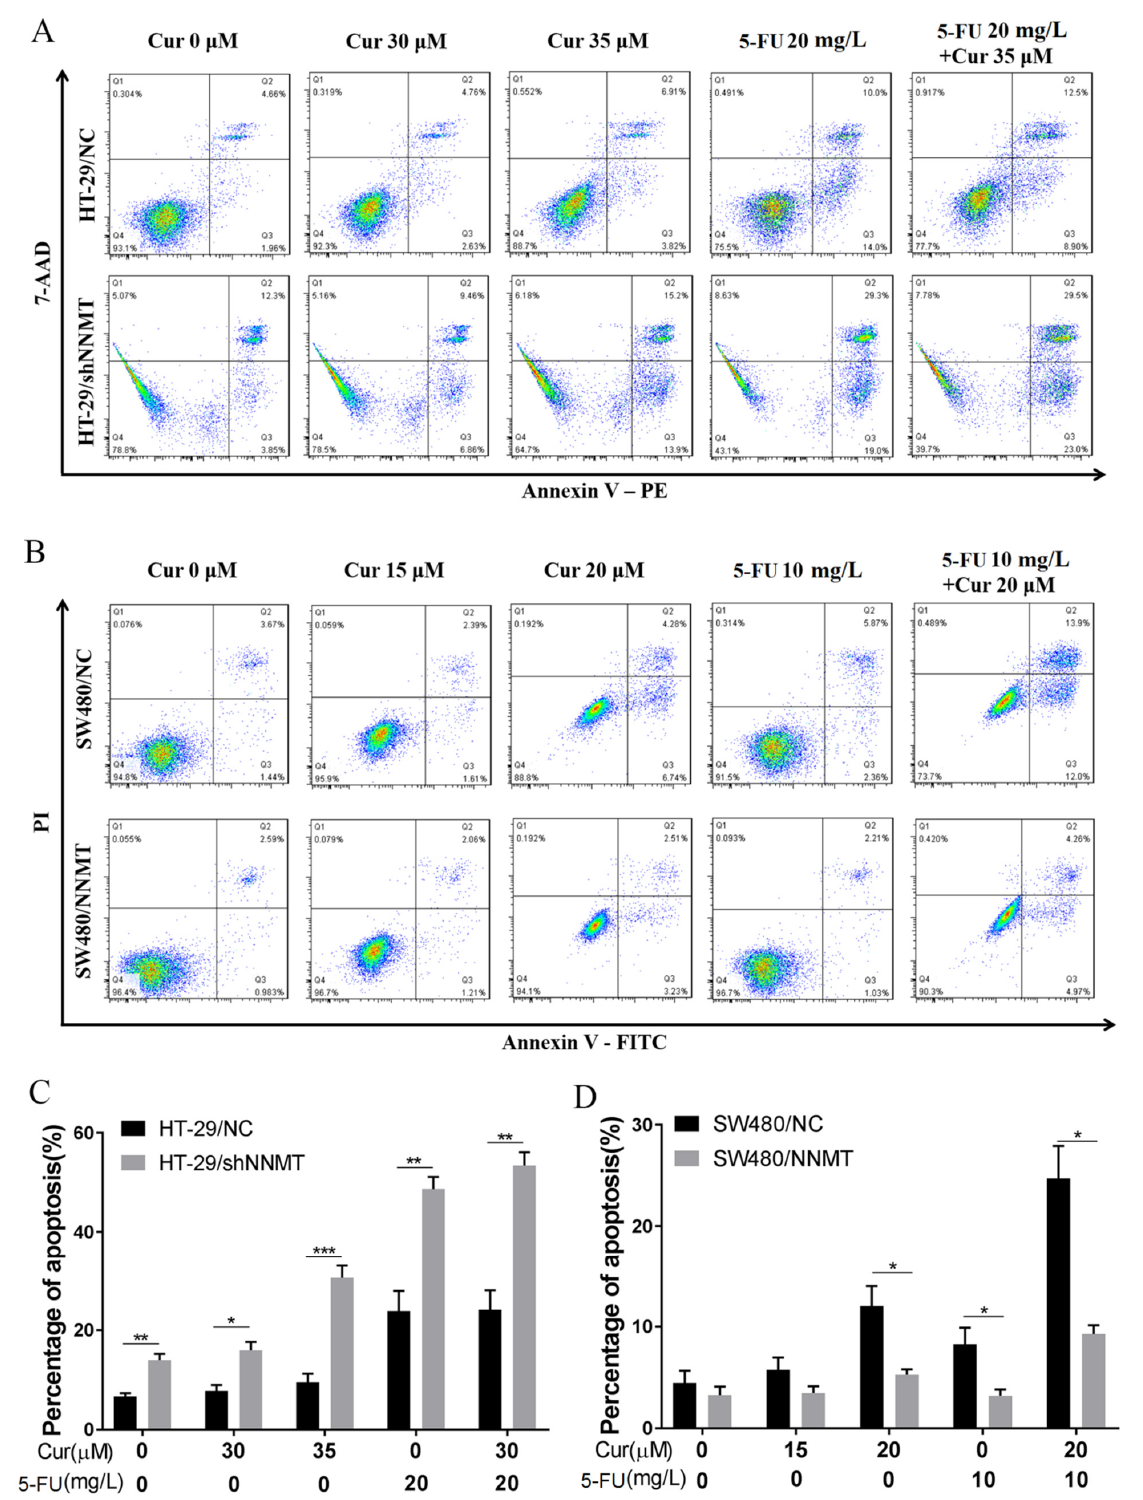
Figure A1. Cur combined with 5-FU induces cell apoptosis in CRC cells. Cells were treated with Cur (30 μ M and 35 μ M for HT-29 cells; 15 μ M and 20 μ M for SW480 cells) and/or 5-FU (20 mg/L for HT-29 cells; 10 mg/L for SW480 cells) for 24 h. ( A , C ) Cell apoptosis was analyzed by flow cytometry and displayed as a histogram of HT-29 cells. ( B , D ) Cell apoptosis was analyzed by flow cytometry and displayed as a histogram of SW480 cells. 5-FU: 5-Fluorouracil, Cur: curcumin. Data are expressed as means ± SD, n = 3, * p < 0.05, ** p < 0.01, *** p < 0.001.